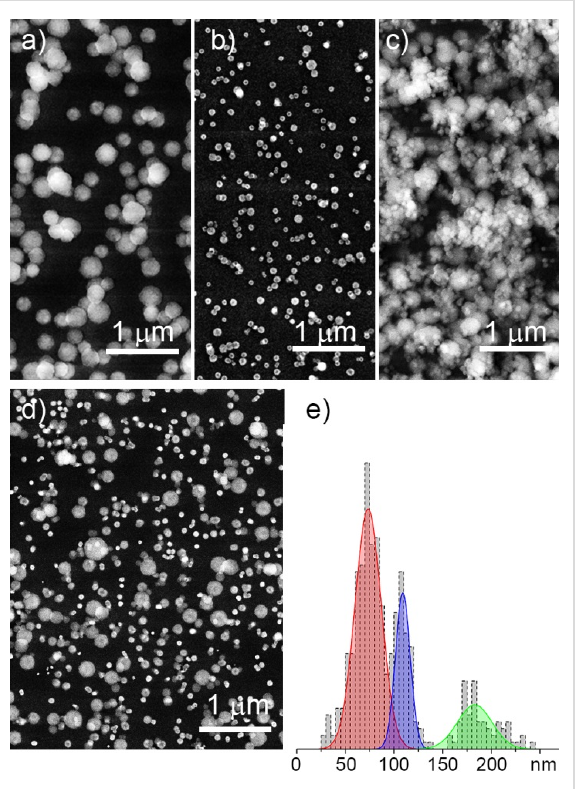
Figure 11: SEM images of NPs prepared by plasma polymerization of HMDSO in Ar: a) 220 nm NPs produced with 10 cm aggregation length; b) 40 nm NPs produced with 4 cm aggregation length; c) dual- scale structure produced by sequential deposition of a) and b); d) triple-scale structure produced by power-dependent sequential deposition of 200, 110 band 70 nm diameter NPs; e) size distribution